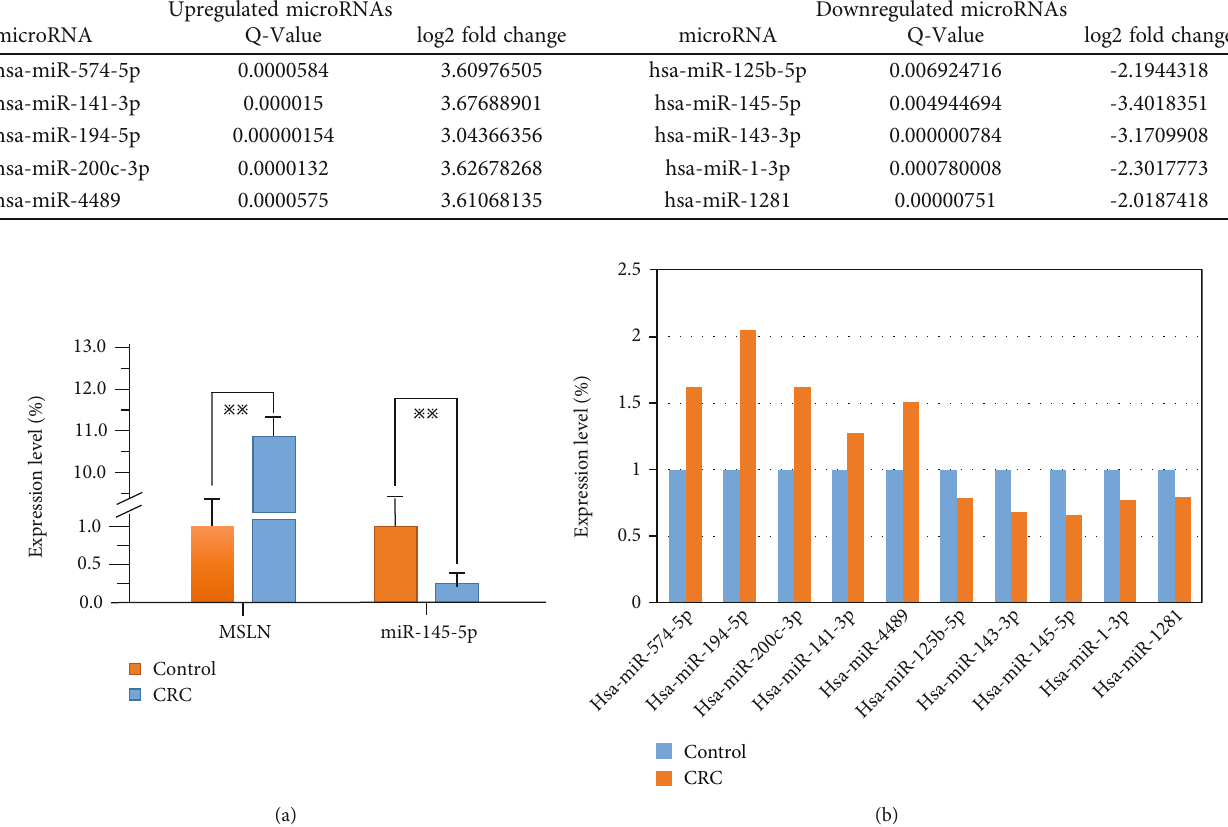
Figure 4: The relative expression levels of miR-145-5p and MSLN in 10 cases of colorectal cancer (CRC) and 10 cases of adjacent normal margin (control). (a) The relative expression levels of miR-145-5p and MSLN in 10 CRC tissues and 10 control tissues, respectively ð P < 0 : 01 Þ . (b) Relative expression levels of CRC-related miRNAs in cancer